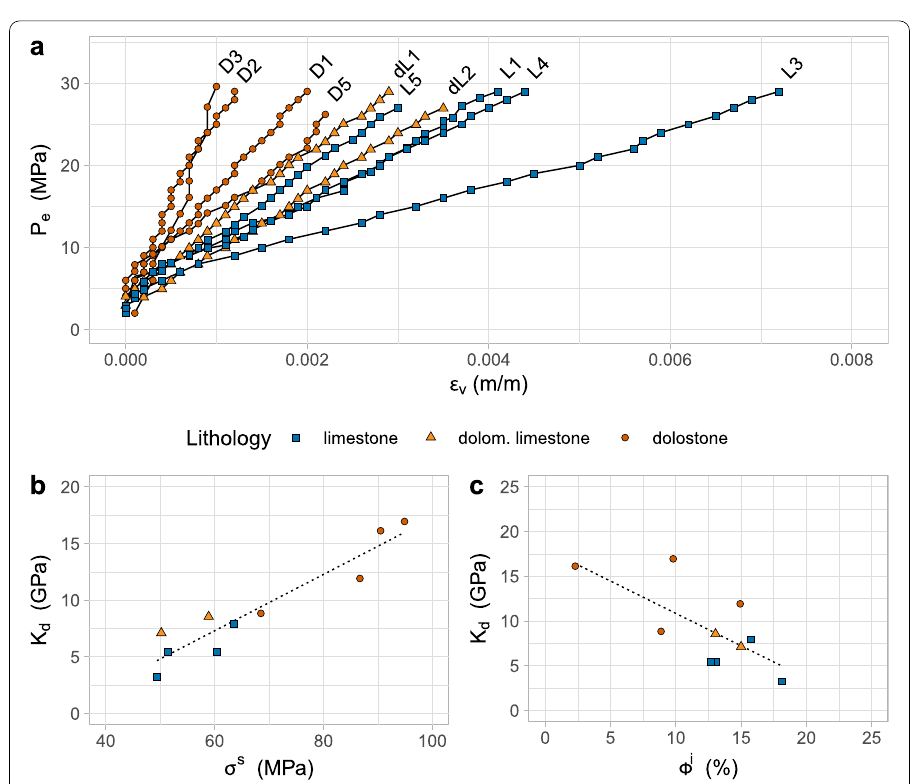
Fig. 8 Stress–strain relationships in hydrostatic compression tests. a Bulk volumetric strain is the response of the tested volume to compressive stress during loading. Limestones generally show higher deformation than dolomitic limestones and dolostones. b Drained bulk modulus K d , calculated as the slope of the stress–strain curve at an effective pressure of 25 MPa, shows a distinct positive correlation with uniaxial rock strength. c With increasing porosity more pore volume can be compressed and the drained bulk modulus K d decreases significantly due to the weakening of the rock